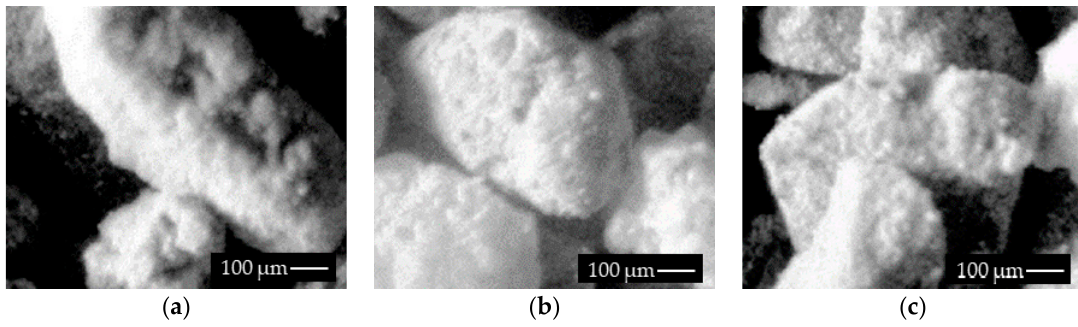
Figure 10. Samples of grains localization. Elongated grain ( a ), oval grain ( b ), covered grain ( c ).